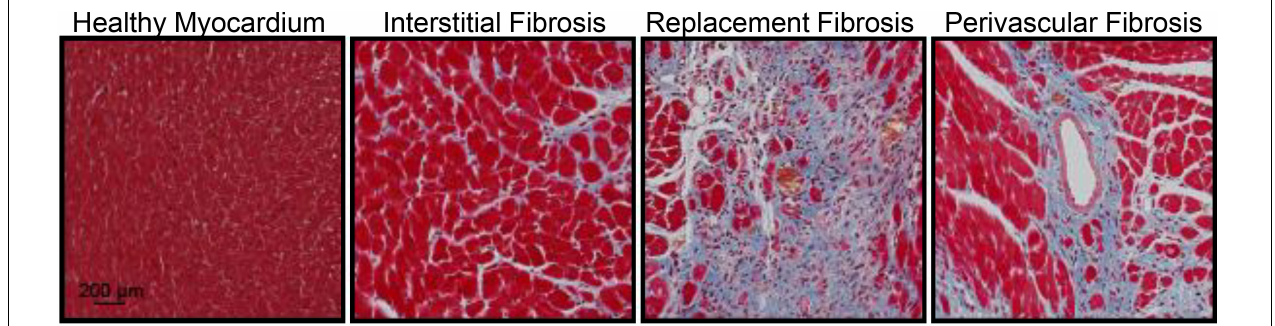
FIGURE 1 | Masson’s trichrome staining of the mouse heart demonstrating fibrosis (blue) in the healthy myocardium, interstitial fibrosis following isoproterenol administration (30 mg/kg/d for 2 weeks), replacement fibrosis after myocardial infarction (4 weeks) or perivascular fibrosis following isoproterenol infusion (30 mg/kg/d for 2 weeks). Red represents the cytoplasm and black represent nuclei. Animal procedures were performed in house with approval by the Institutional Animal Care and Use Committee at the University of Missouri and in accordance to the National Institutes of Health Guidelines on the Use of Laboratory Animals .